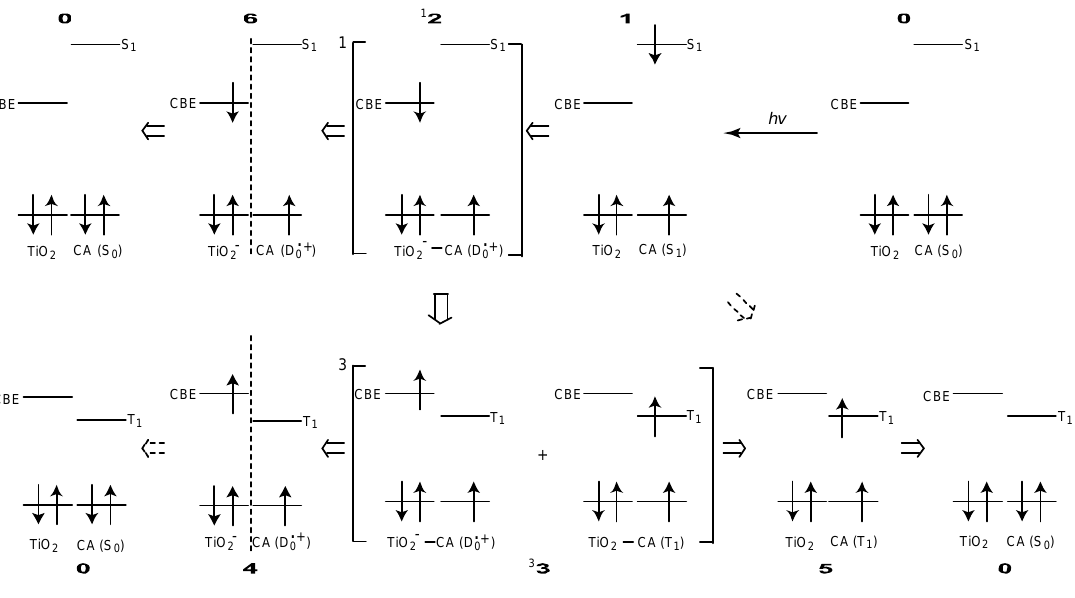
Figure 12. Excitation, electron transfer and relaxation dynamics in a typical Car bound to TiO nanoparticles in suspension. Mechanisms of electron injection as well as charge 2 recombination, following intersystem crossing and exciplex formation, to generate